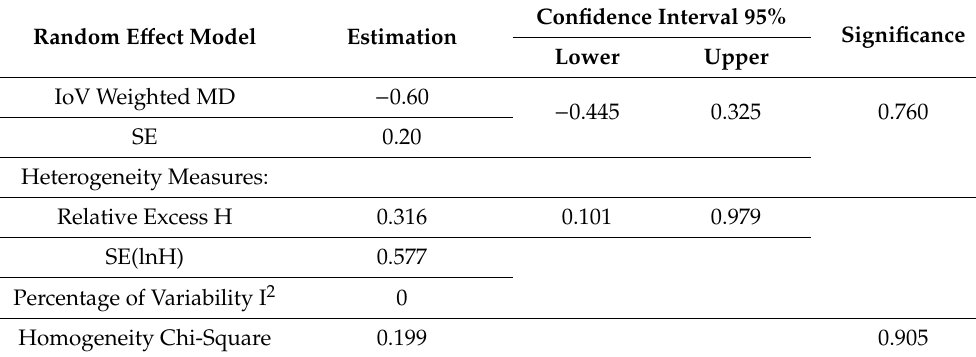
Table 7. Summary of Heterogeneity